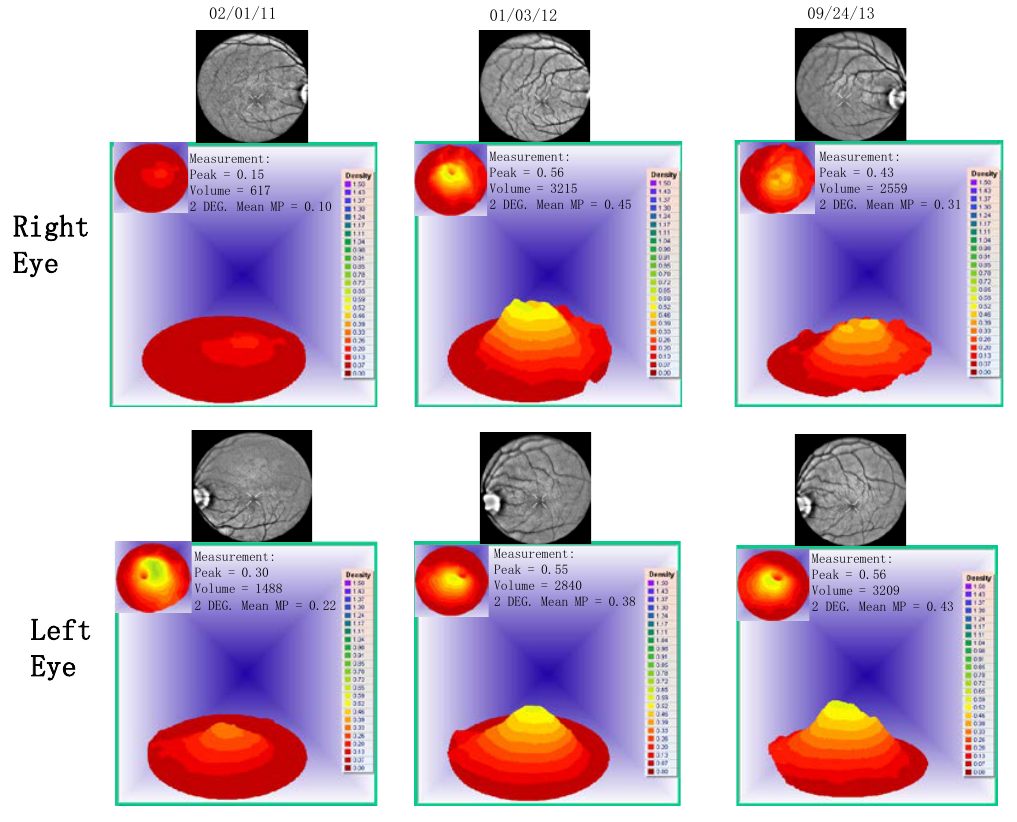
Figure 3. Visualized macular pigment volume of a 64-year-old male patient with AMD and diabetes type 2. With time, approximately 2.5 years, there is bilateral increased macular pigment with no change in reported dietary or supplemental carotenoid/omega-3 intake, an unusual clinical